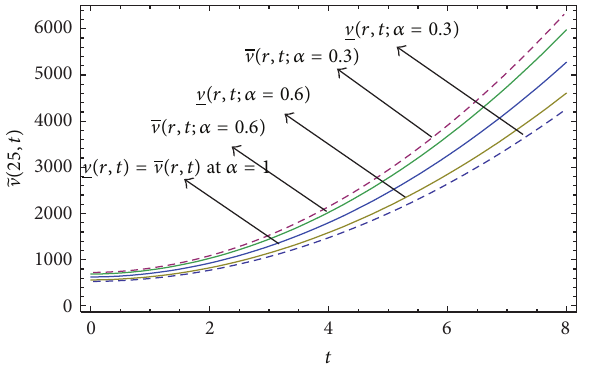
Figure 12: Interval solution of Case 2 at 𝑡 = 8 .